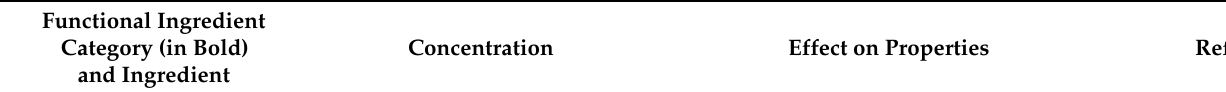
Table 5. Some of the useful functional ingredients that have been incorporated into probiotic yogurt including their concentration and effect on the properties of the resulting